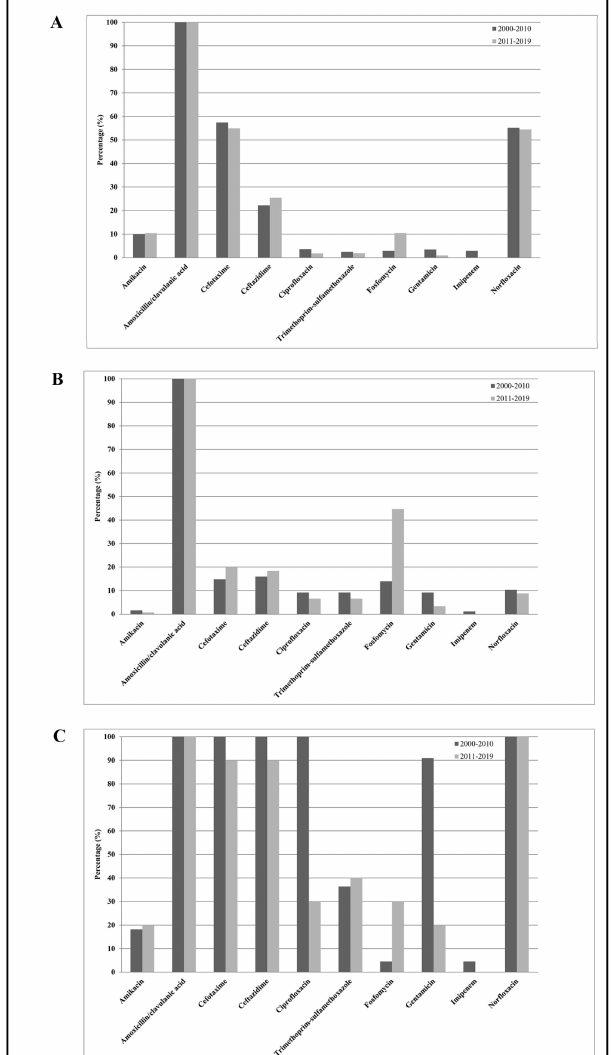
Figure 3. Distribution of mean antibiotic resistance percentages of Enterobacter cloacae isolates against the 10 antimicrobial agents tested, amikacin, amoxicillin/clavulanic acid, cefotaxime, ceftazidime, ciprofloxacin, norfloxacin, fosfomycin, gentamicin, imipenem, and trimethoprim-sulfamethoxazole, among all subjects enrolled in the study ( A ), among outpatients ( B ), and among hospitalized subjects ( C ) during the study periods 2000–2010 and